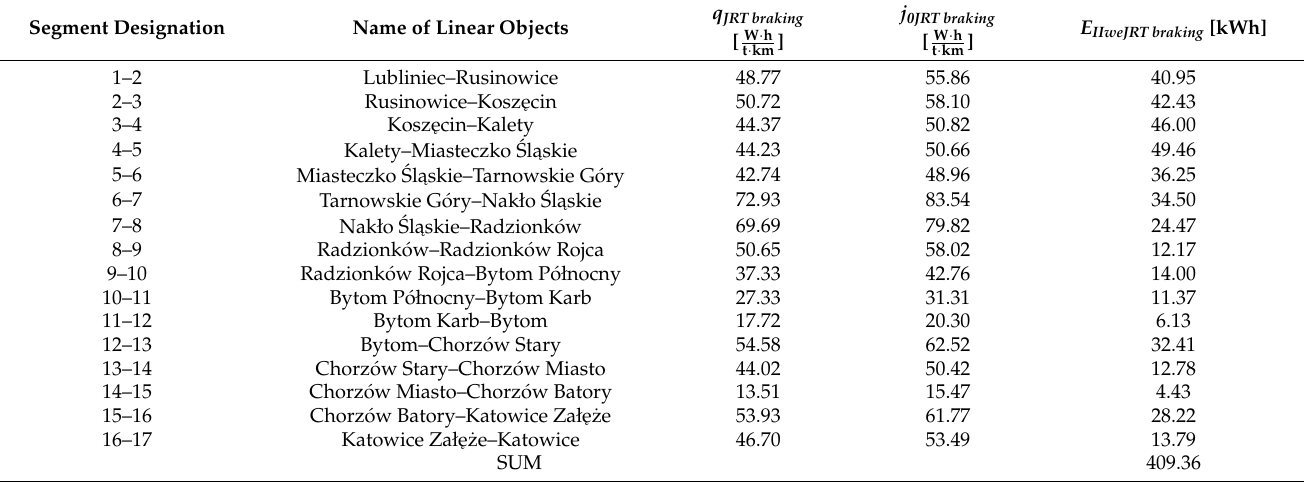
Table 3. Calculated electricity consumption values q JRT braking , j 0JRT braking and E IIweJRT braking (Variant II, the new approach for braking on jointed railway